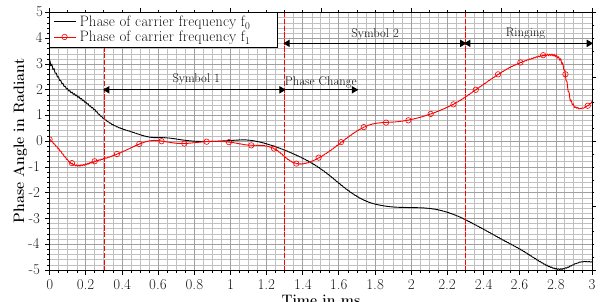
Figure 13. Measured phase angle of the received signal over time. The phase angles remain stable in the middle of the symbol. At the beginning of the second symbol the phases vary due to the phase ≈ − 2 . 6 and (cid:56) f ≈ 0 . 8 in the shifts. The received phase angles (cid:56) f 0 1 center of the second symbol coincide with the transmitted phase angles π + π/ 4 ≈ − 2 . 36 for f 0 and π/ 4 ≈ 0 . 79 for f 1 .